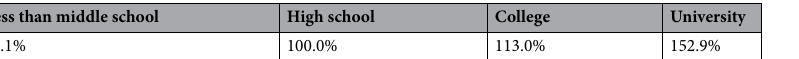
Table 3. Relative wage index by education in South Korea (1998–2018). OECD 41 . The relative wage index